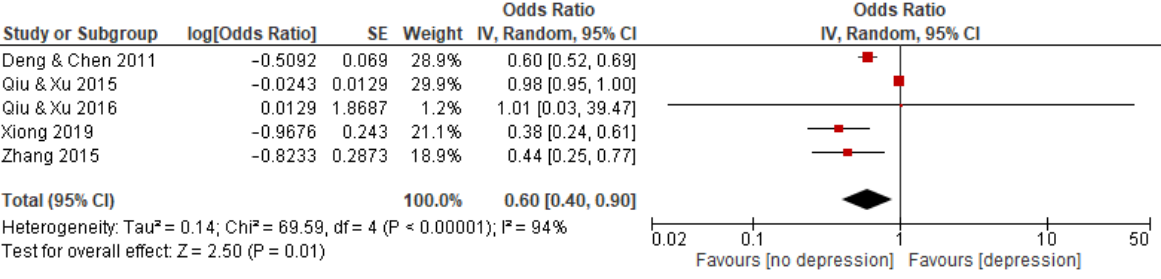
Figure 6. Forest plot of studies on association between BC and depression. Note: red square represents the result of each study; line represents the 95% CI of the results; diamond represents the pooled results.